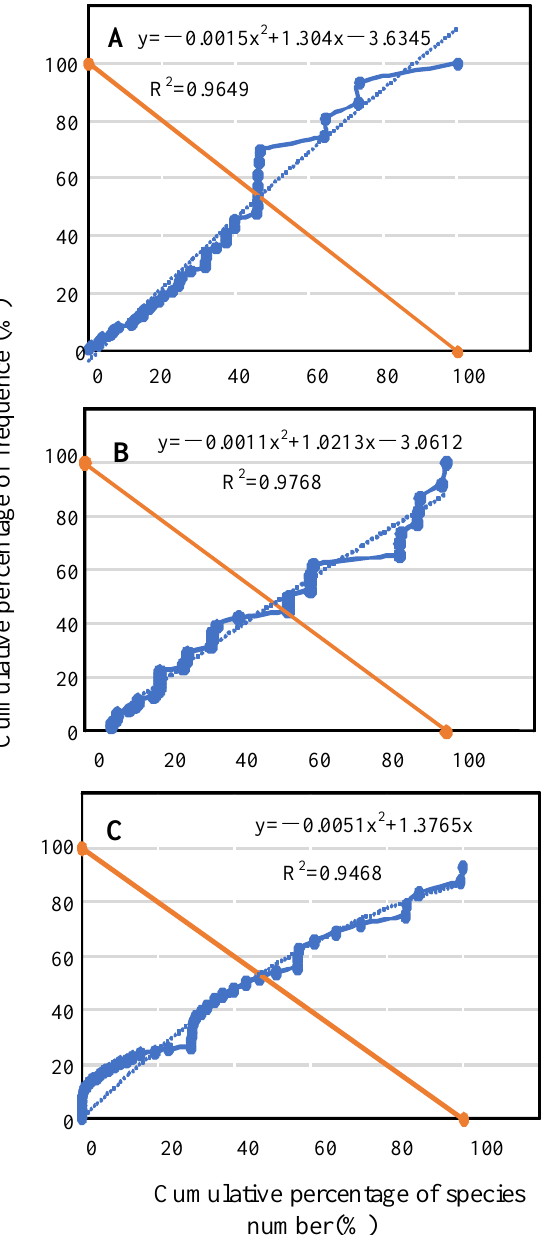
Figure 6. Stability of tree stand types. ( A ) = natural forest; ( B ) = abandoned fallows; ( C ) = planted forest. Table 8. Changes in stability parameters in relation to stand type.